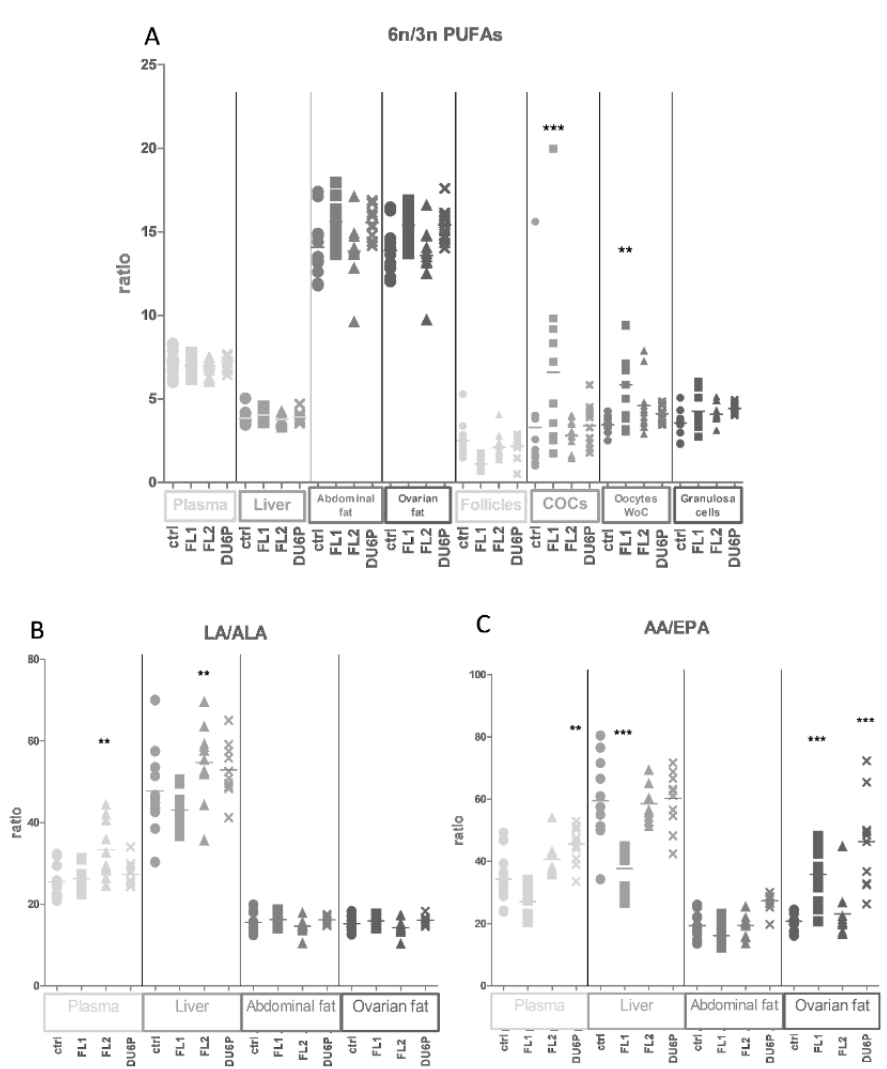
Figure 6. Fatty acid composition in control (circles), FL1 (squares), FL2 (triangles) and DU6P (crosses). ( A ) shows the PUFA n-6/n-3 ratio in plasma, liver, abdominal and ovarian fat, follicles, COCs, oocytes WoC (without cumulus) and granulosa cells. ( B , C ) show the ratio between the n-6 LA and the n-3 ALA ( B ) and the n-6 AA and the n-3 EPA ( C ) in plasma, liver and fat. Different tissues are represented using different tonalities and dimensions. Data are illustrated as the mean ± SEM (standard error of the mean) and designated significant if p < 0.05 (Bonferroni posttest: ** p < 0.01; *** p < 0.005, in comparison with control of the same group).